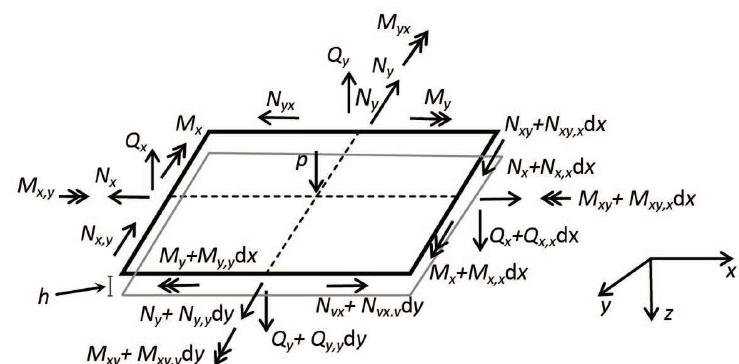
Figure 2. Force diagram at the middle surface of a laminated